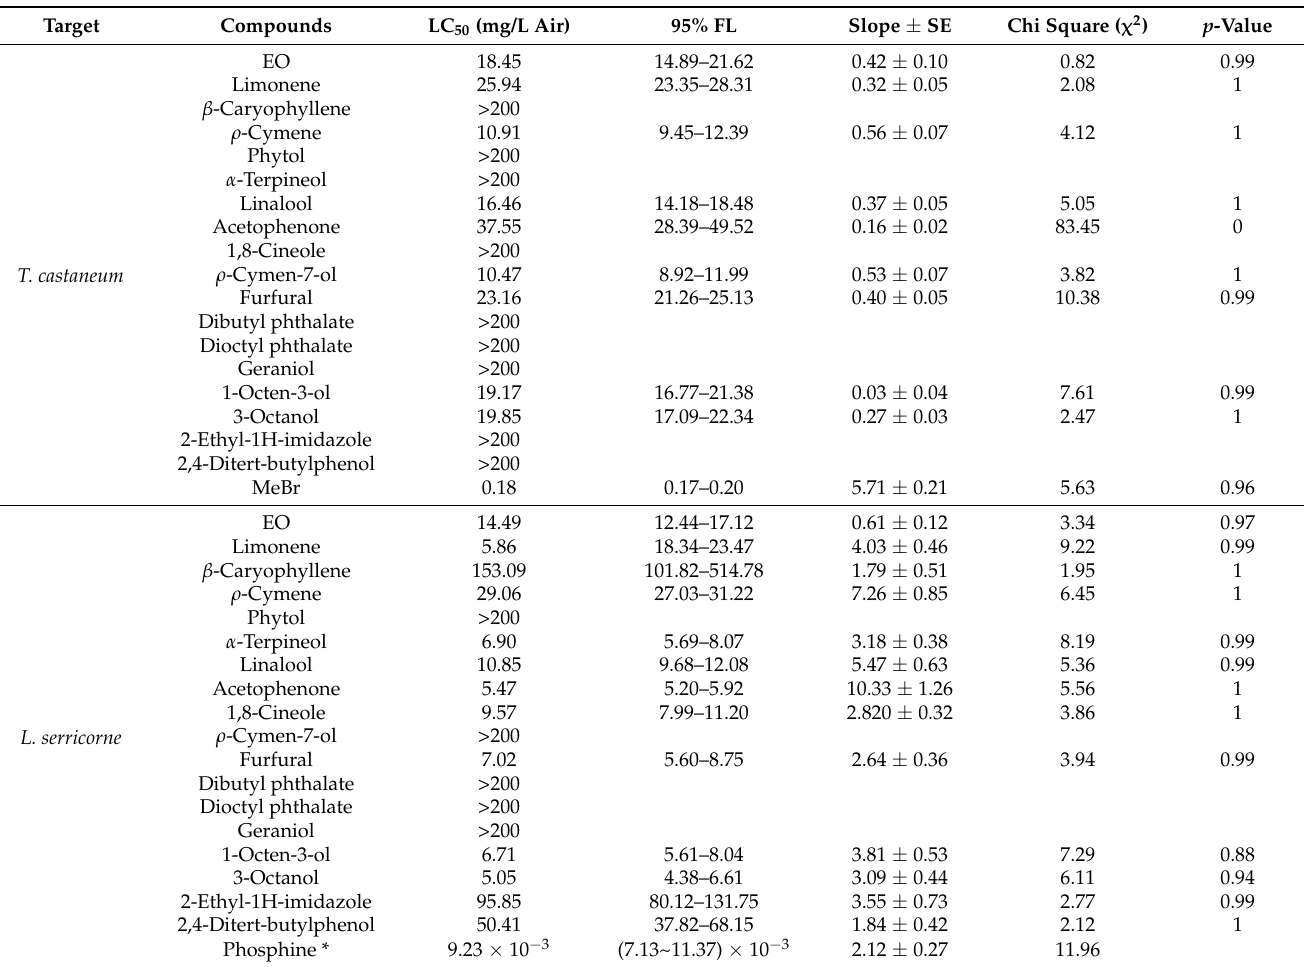
Table 5. Fumigant activity of compounds against T. castaneum and L. serricorne . Target